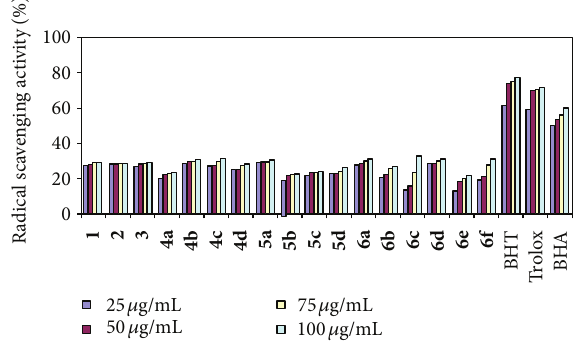
Figure 6: Radical scavenging activity (%) of different concentration of new compounds.